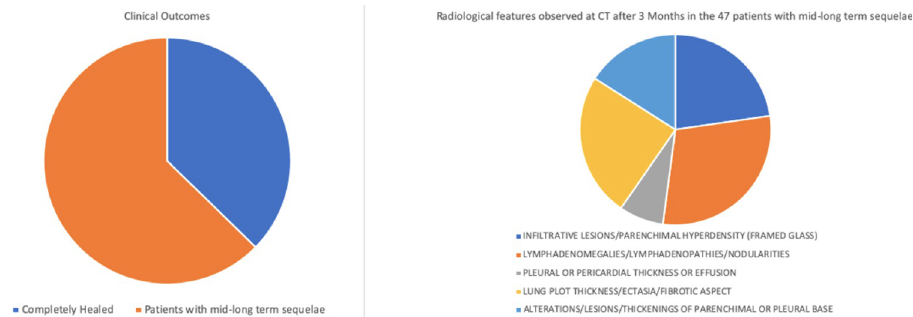
Fig 3. Clinical outcomes. Clinical outcomes (28 patients completely healed + 47 patients showing persistence of radiological sequelae) after 3 months from the hospital admission due to interstitial pneumonia (mild to moderate symptoms) and classification of the radiological sequelae observed in case of disease